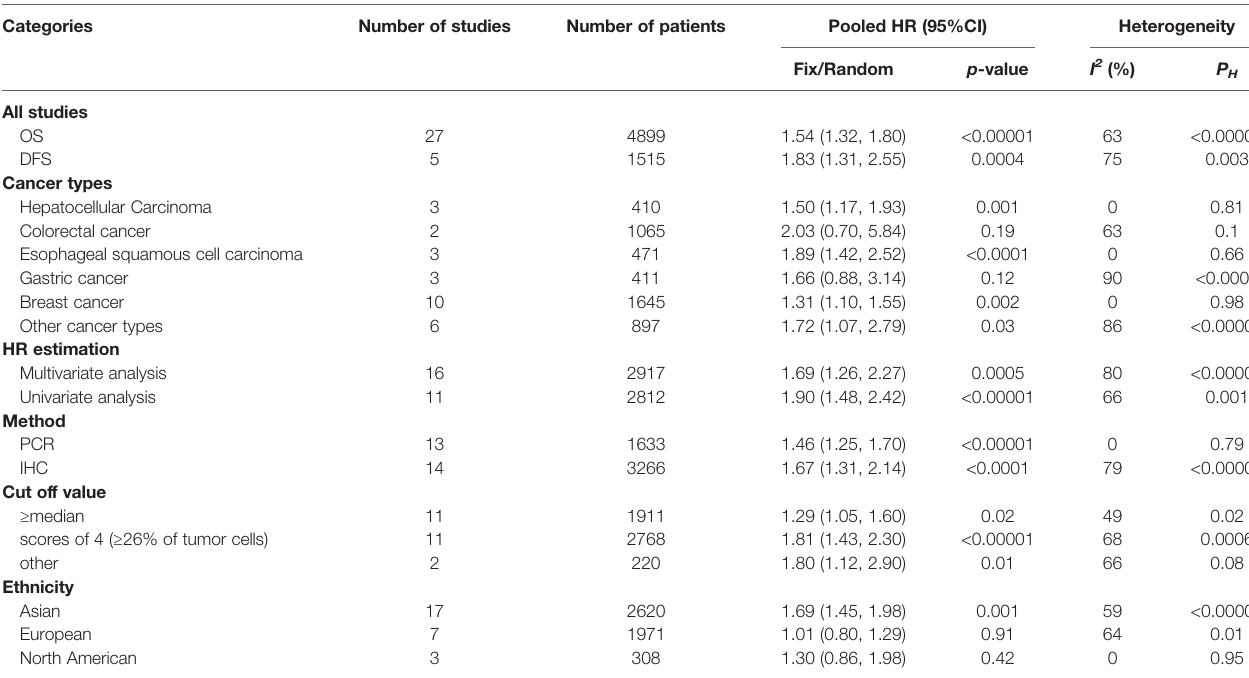
TABLE 2 | Subgroup analysis of pooled HR for OS.